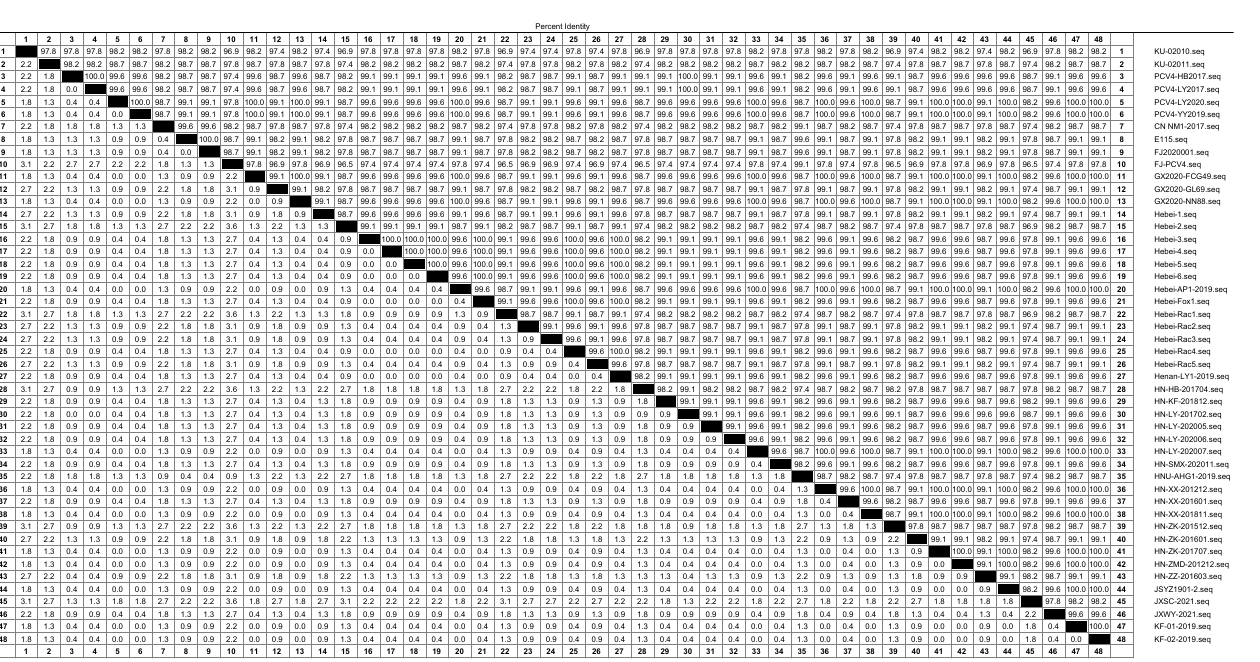
Figure 1. Sequence distance of the complete genome sequences between twelve PCV4 strains obtained in this study and representative PCV4 strains.